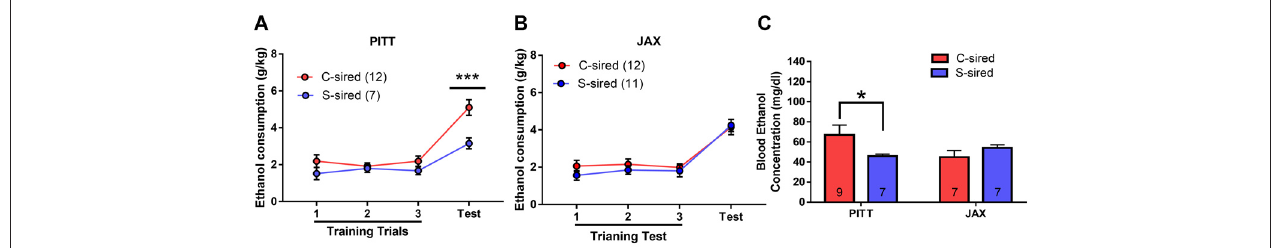
FIGURE 10 | Sire-source dependent paternal stress reduces binge-like ethanol drinking. (A) Significant effect of paternal chronic variable stress on ethanol consumption in PITT-sired offspring. (B) No effect of JAX pre-stress sire conditions on ethanol consumption. (C) Significant effect of paternal chronic stress on blood ethanol concentrations following the 4-h drinking in the dark test trial for PITT, but not JAX S-sired vs. C-sired male offspring ( N = 7–12/group for PITT-sired males and 12/group for JAX-sired males). ∗ p < 0.05, ∗∗∗ p < 0.001.